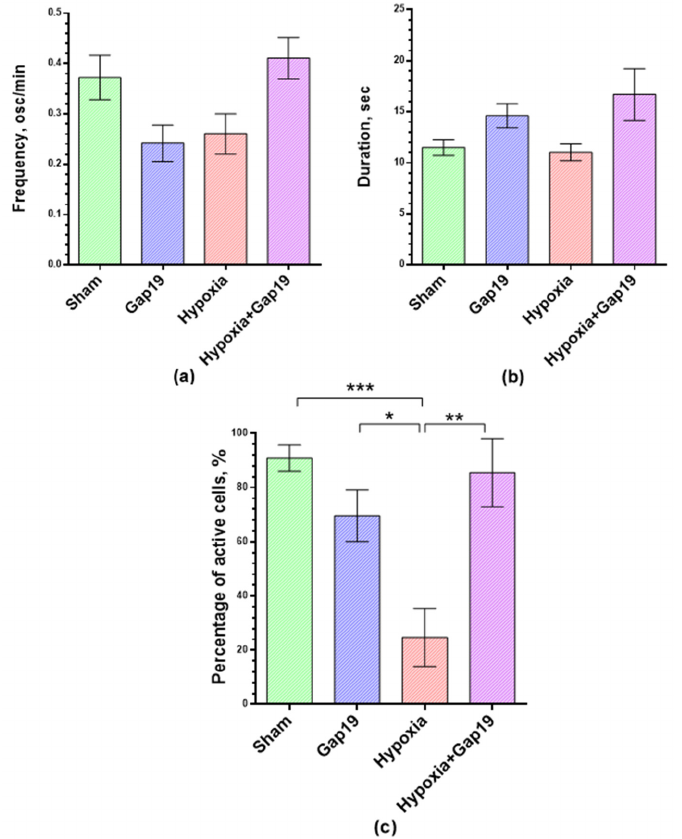
Figure 4. Main parameters of functional calcium activity of primary cortical cultures on the third day of the post-hypoxic period. ( a ) Number of Ca 2+ oscillations per min; ( b ) duration of Ca 2+ oscilla- tions; ( c ) proportion of cells exhibiting Ca 2+ activity. * p < 0.05; ** p < 0.01, *** p < 0.001, Kruskal– Wallis test.